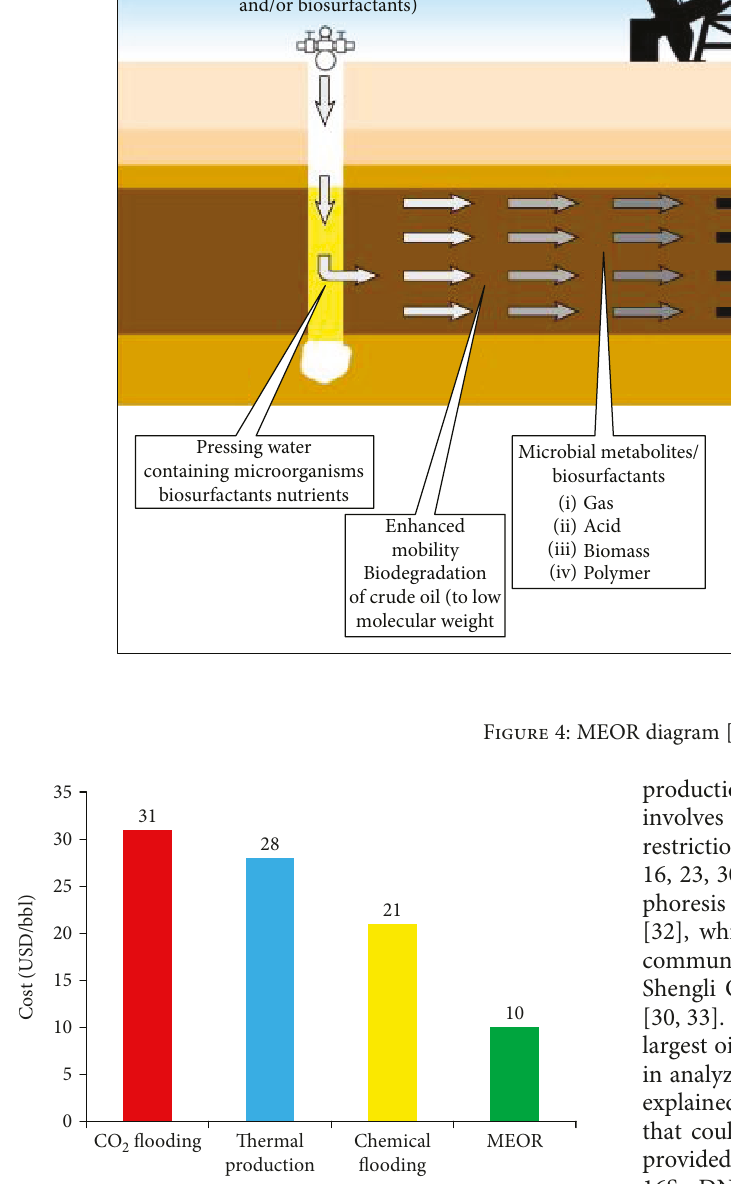
Figure 5: Di ff erent EOR technique cost estimation